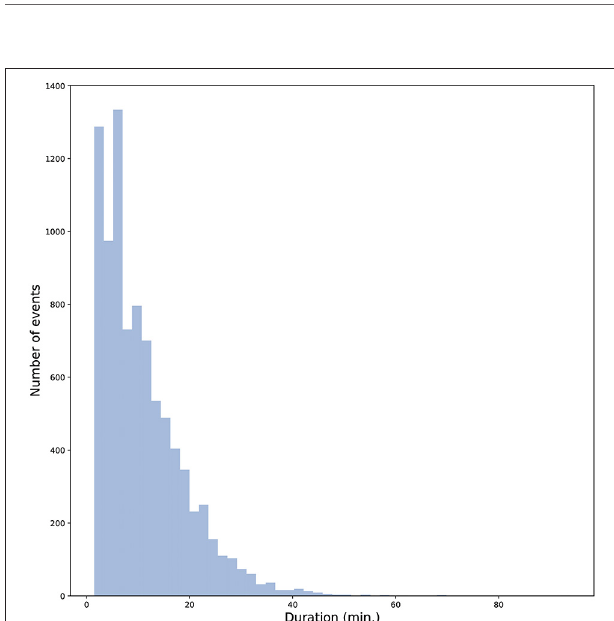
FIGURE 6 | Frequency distribution of the estimated duration for the whale watching events.